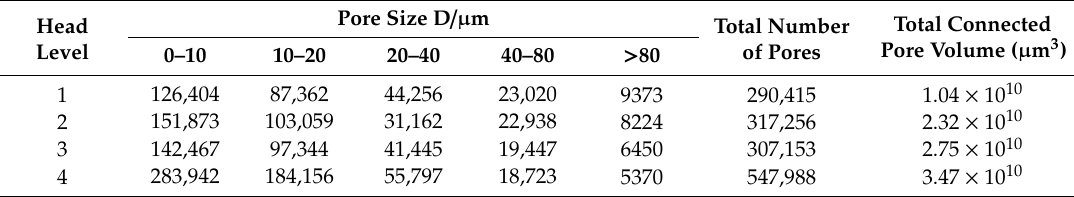
Table 5. Statistics of the number of pores in the seepage process with the 50% fine content.